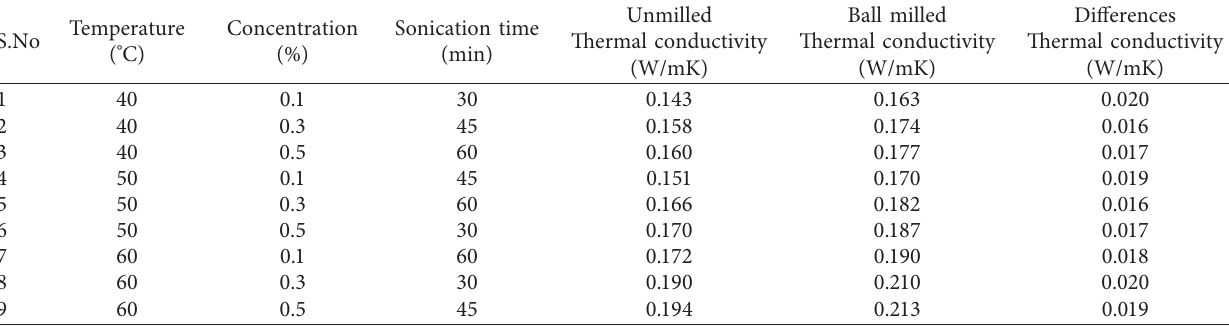
Table 1: Experimental data for thermal conductivity of NPDP.